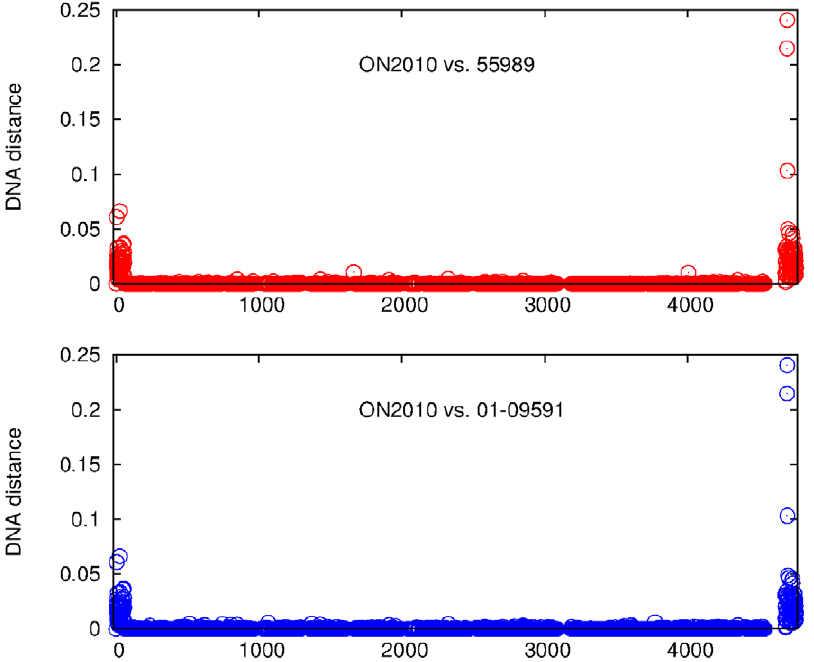
doi:10.1371/journal.pone.0033971.g007